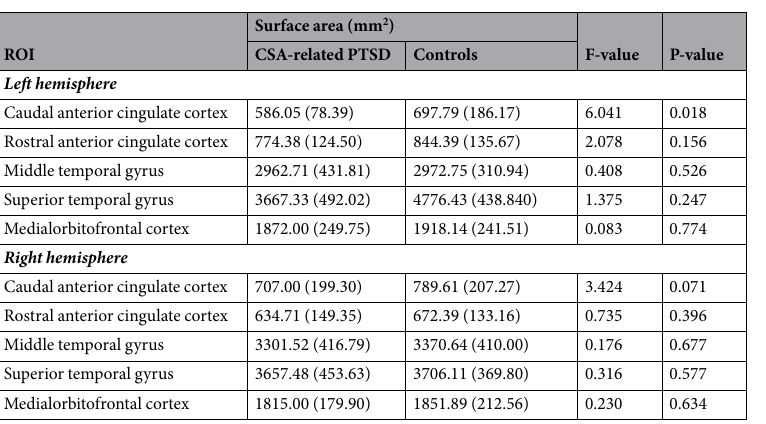
Table 3. Contributions of each ROI’s surface area. Abbreviations: CSA, Childhood Sexual Abuse; PTSD, Post Traumatic Stress Disorder.